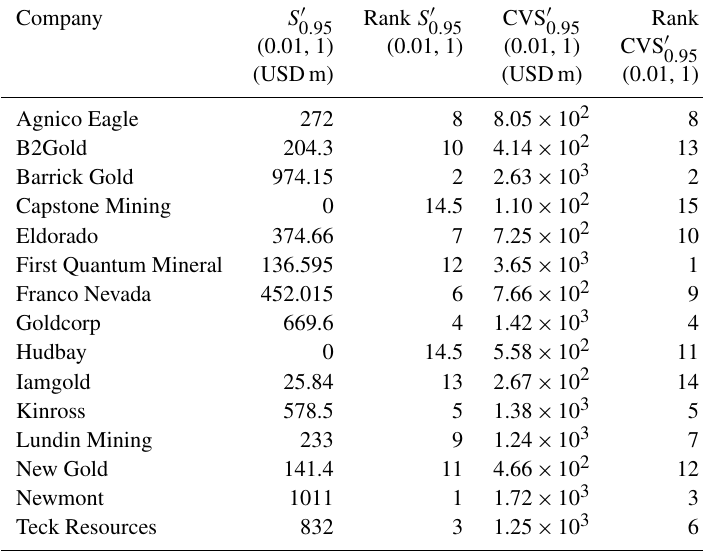
Table 1. Ranking of 15 companies based on S (cid:48) 20CR dataset and mine valuation obtained from broker reports from TD Securities.